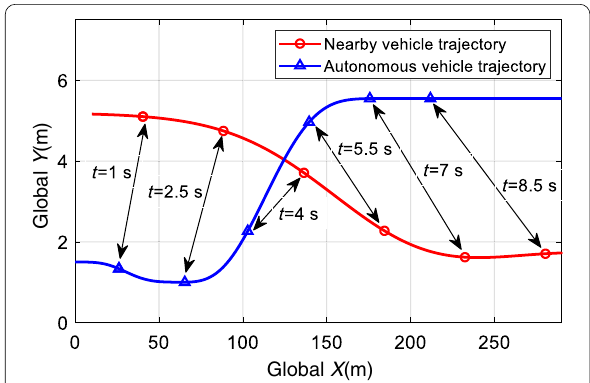
Figure 9 Vehicle trajectories in the lane-exchanging scenario when initial longitudinal distance is 30